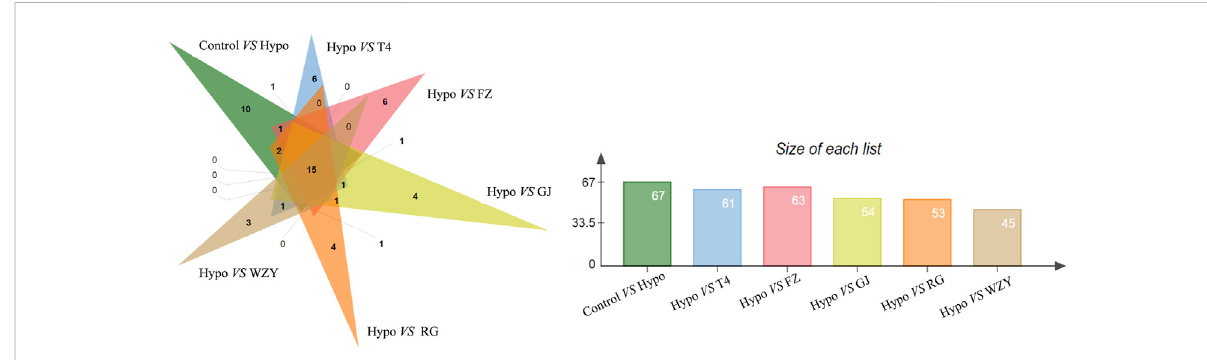
The Veen analysis of potential biomarkers in the four typical “ hot ” property herb